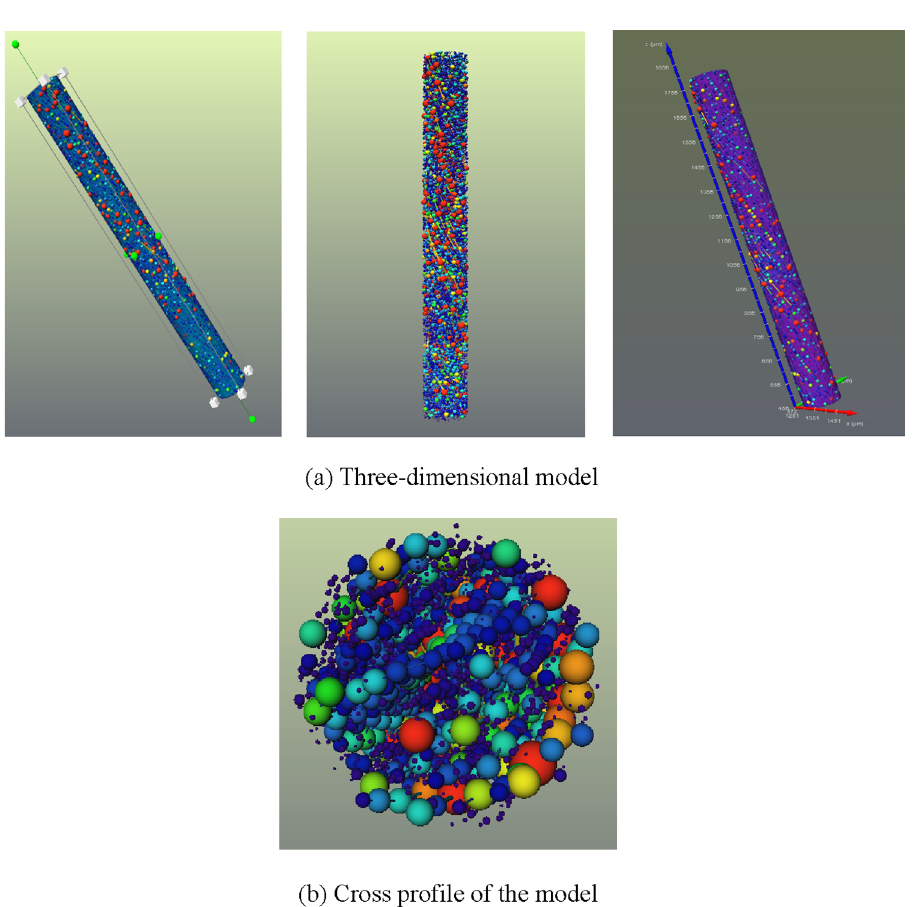
Figure 17. Nylon-rubber pore network model.